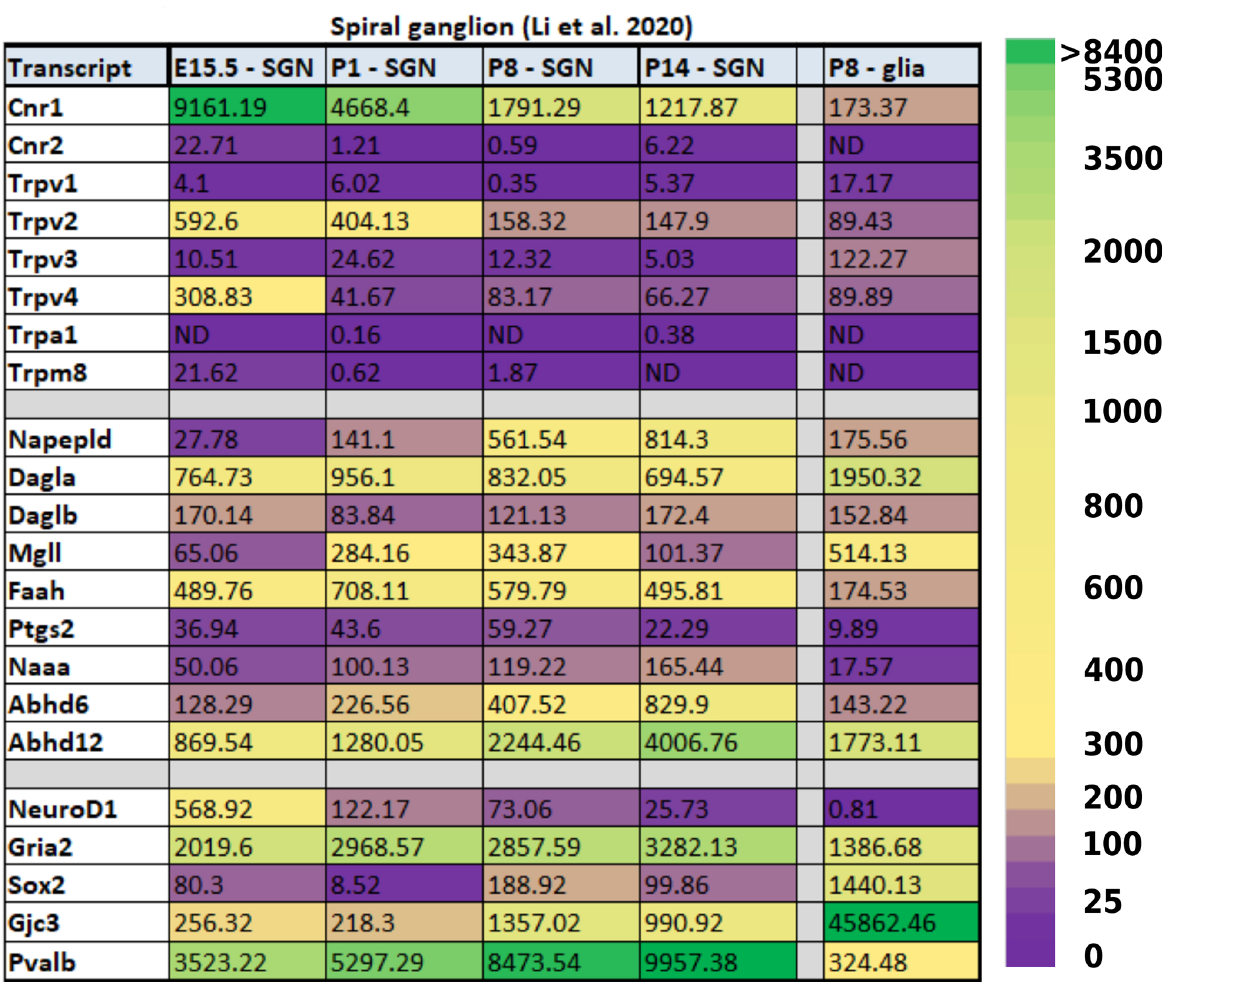
TABLE 3 | Expression of ECS-related transcripts in the developing spiral ganglion. Data were obtained from Li et al. (2020) and are presented as counts per million (CPM) mapped reads. Transcripts presented in the bottom five rows are not known to be directly related to ECB signaling, but are presented to provide reference values for transcripts that are expressed in the SGNs at higher (NeuroD1, Gria2, Pvalb) and lower (Sox2, Gjc3) levels, and expressed in glial cells in an inverse